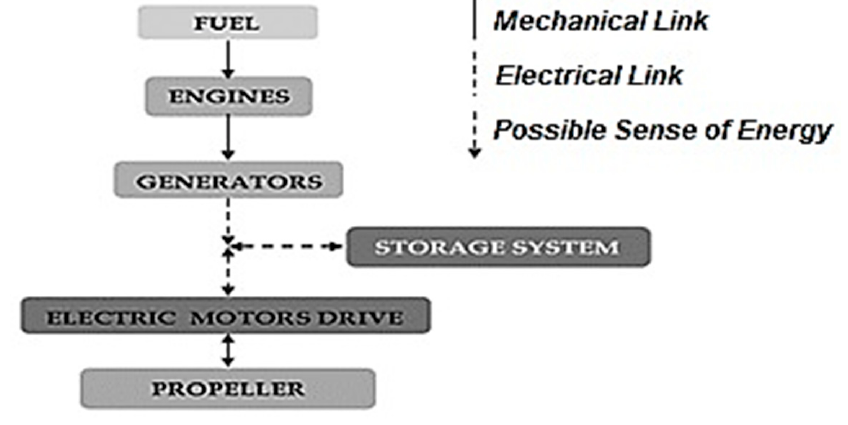
Figure 3. Example of series hybrid propulsion configuration.